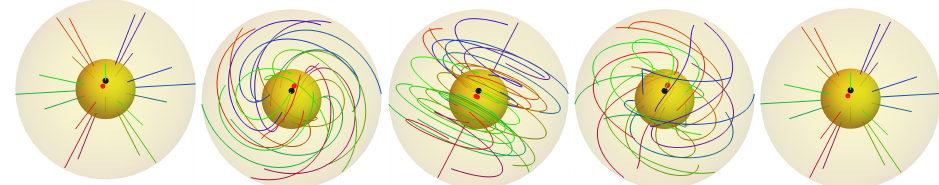
Figure 4. The rotating inner sphere is connected by an arbitrary number of wires to the outer sphere. Rigid spheres of the increasing radius with fixed piercings rotate around varying axes. The inner sphere performs a 4 π rotation around the axis indicated by the black dot. The red dot shows the status of the positive rotation in the sequence 0, π ,2 π ,3 π ,4 π . The set of these rotations corresponds to a big circle on S 3 . For spheres from inside to outside, these sets build smaller and smaller circles contracting at the outer sphere to no